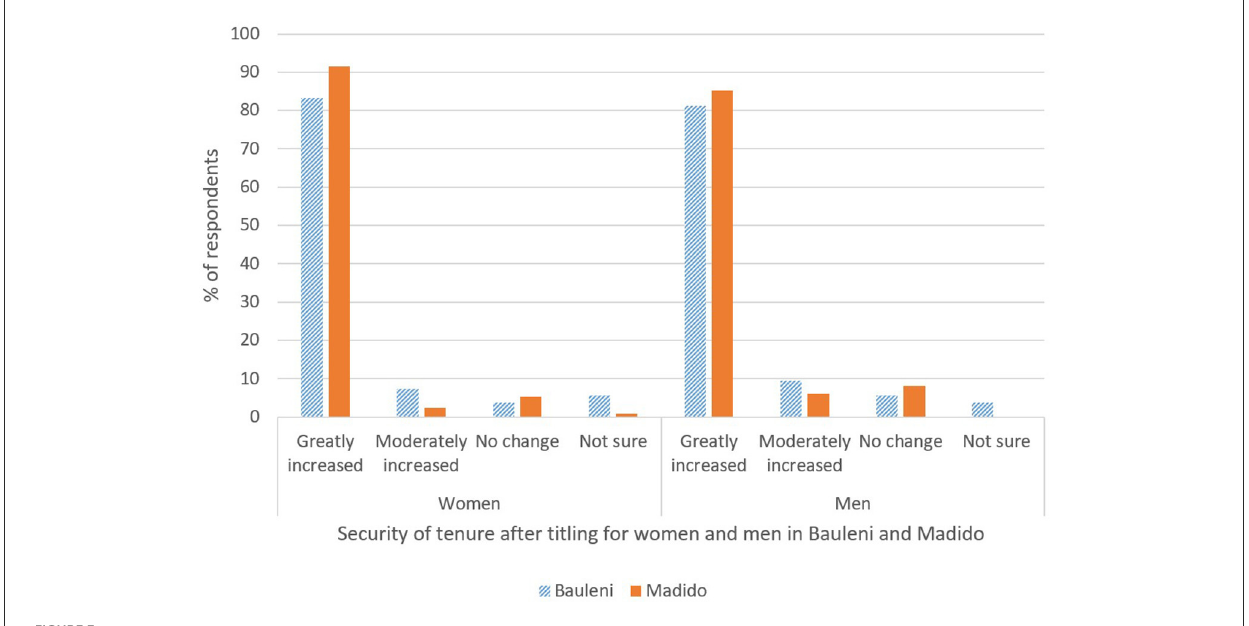
FIGURE3 Sense of tenure security after land titling by women and men in Bauleni and